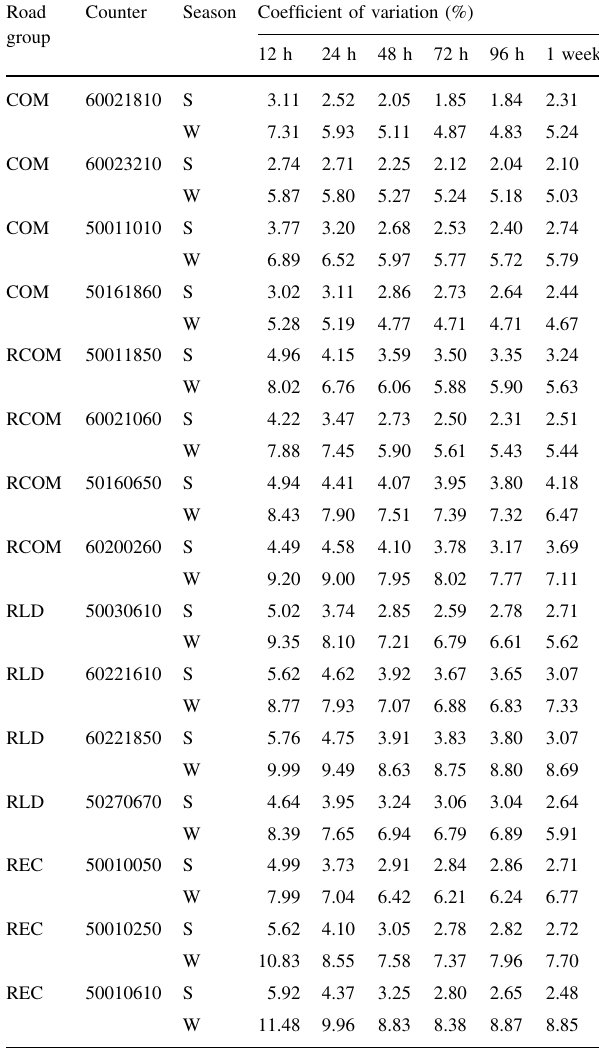
Table 5 CV for different durations of short-period counts at study sites Road Counter Season Coefficient of variation group